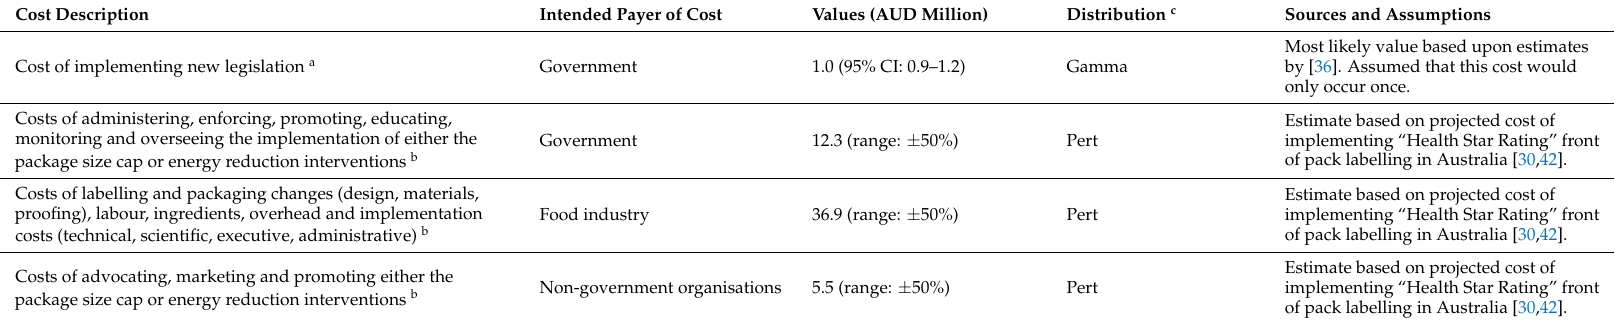
Table 3. Intervention costs (adjusted to 2010 AUD) with associated uncertainty distributions and